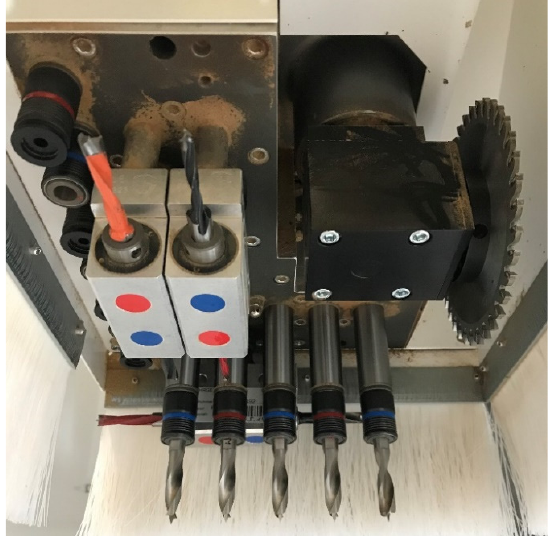
Figure 4. Homag drilling gear V12/H4 × 2Y.